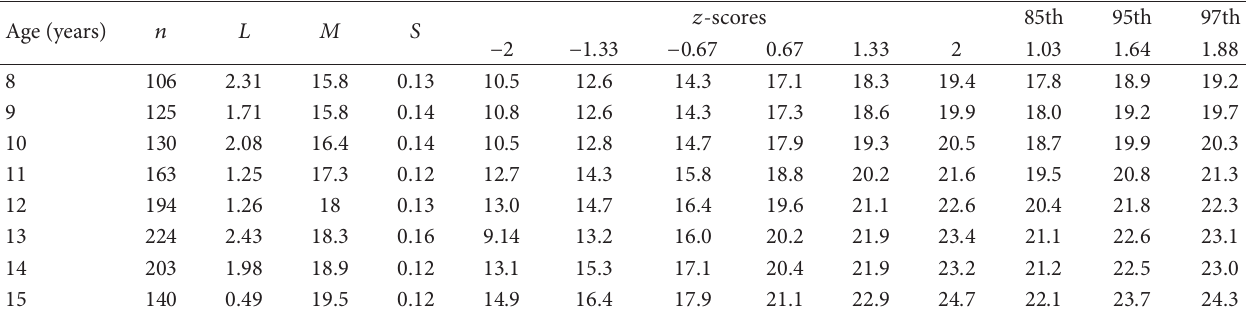
Table 2: Age specific 𝐿 , 𝑀 , 𝑆 , and 𝑧 -scores values for BMI (kg/m 2 ) from Cameroon study population using LMS method, with additional 𝑧 -scores and percentiles: